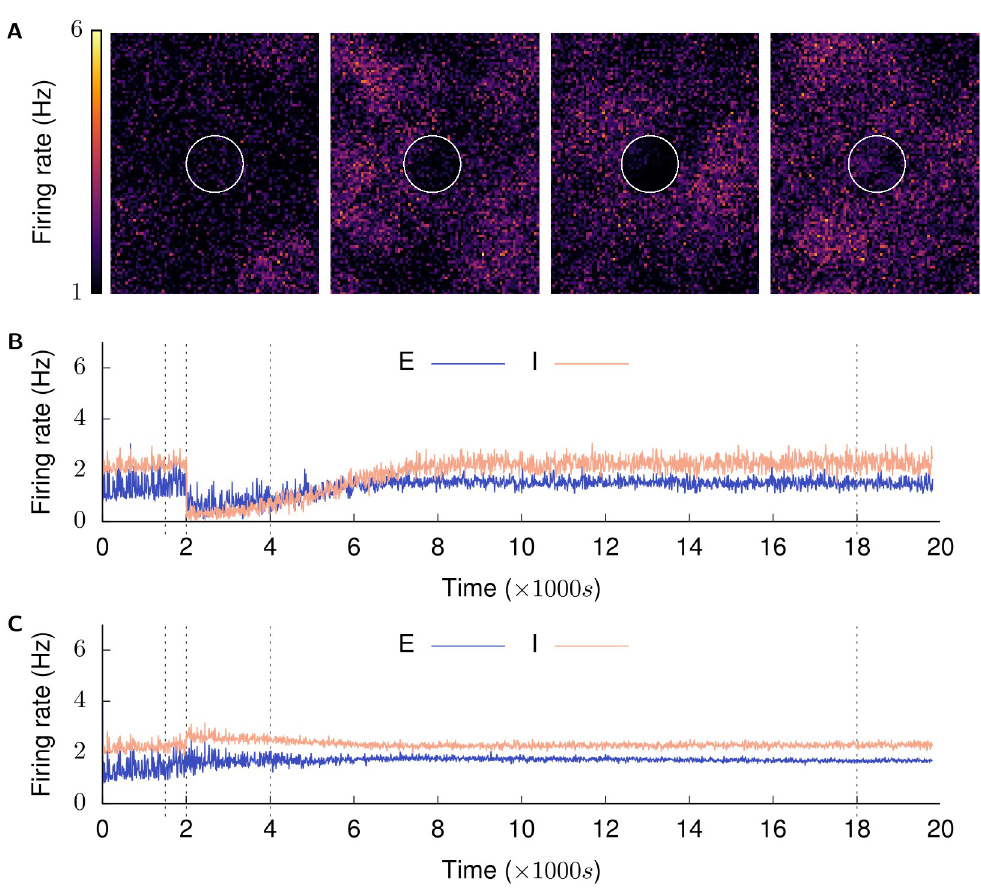
Fig 3. Recovery of activity over time. (Mean firing rates of neurons are calculated over a 2500 ms window and plotted in 100 ms increments.). (A) shows the firing rates of the whole excitatory population at t = {1500 s, 2001.5 s, 4000 s, and 18,000 s}. These are marked by dashed lines in the next graphs. The LPZ is indicated by white circles here and in following figures. (B) shows mean firing rate of neurons in LPZ-C; (C) shows mean firing rate of neurons in peri-LPZ; The network is permitted to achieve its balanced Asynchronous Irregular (AI) low frequency firing regime under the action of inhibitory synaptic plasticity ( t � 1500 s). Structural plasticity is then activated at all neurites—pre-synaptic and post-synaptic, excitatory and inhibitory—to confirm that the network remains in its balanced AI state (panel 1 in A). At ( t = 2000 s), neurons in the LPZ are deafferented (panel 2 in A is at t = 2001.5 s) and the network allowed to repair itself under the action of our structural plasticity mechanism (panels 3 ( t = 4000 s) and 4 ( t = 18,000 s) in